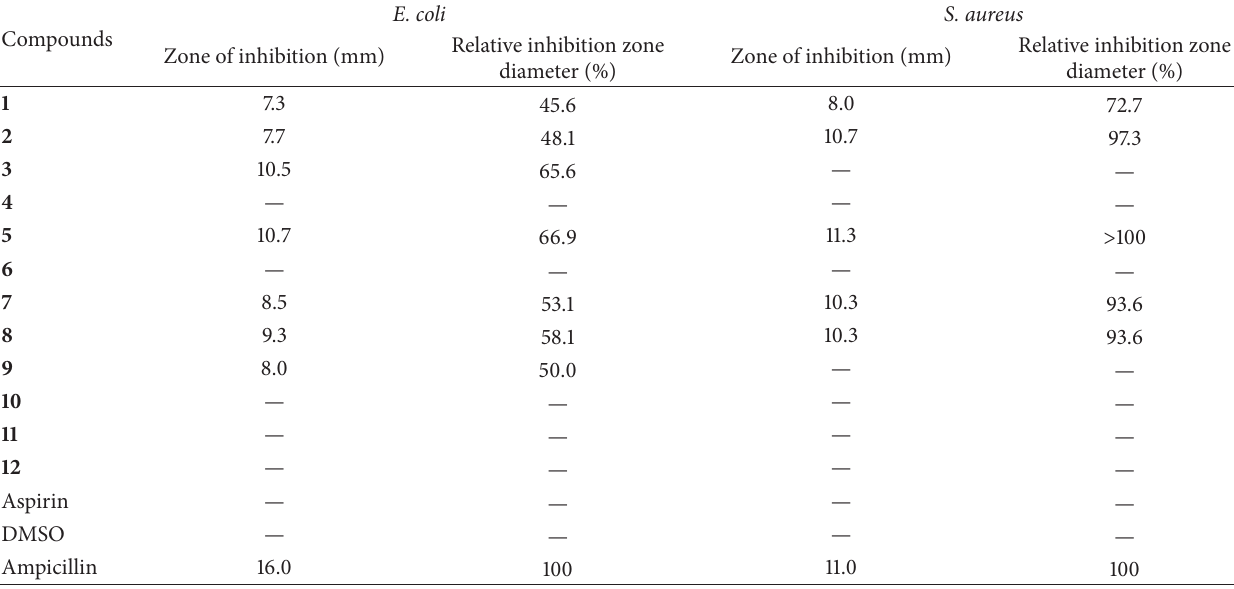
Table 1: Antibacterial activities of 1 – 12 in comparison to aspirin and